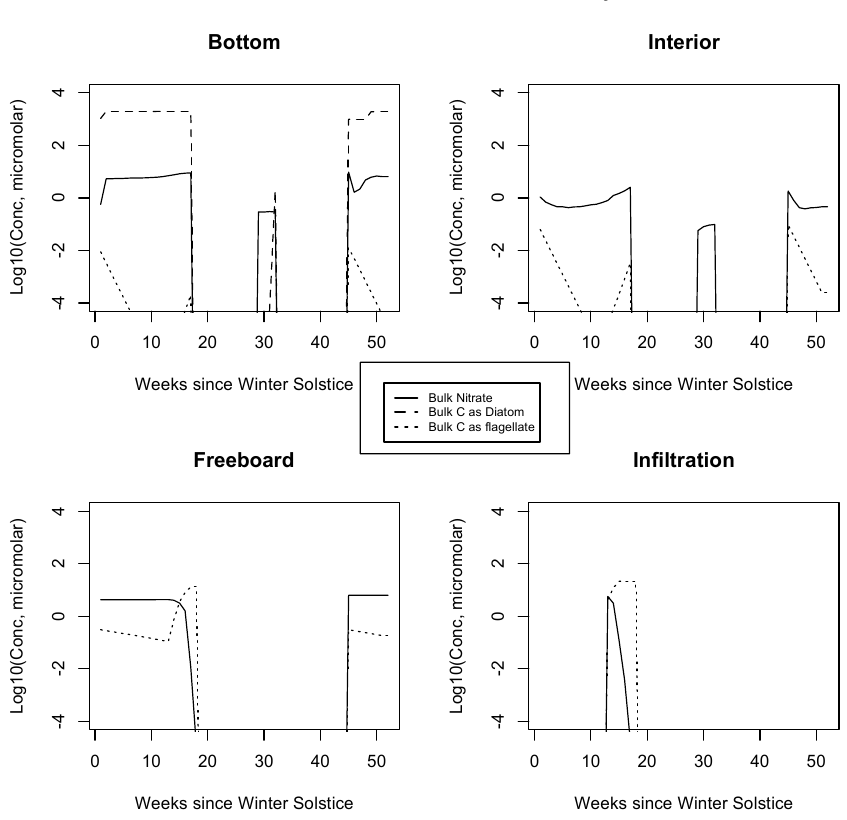
Figure 3. Sea of Okhotsk, bulk nitrogen and carbon concentrations in the baseline run for the four numerical habitat levels. All values are base 10 logarithms for the major indicator atom types from concentrations computed in micromolar. Silicate is not shown since it is present in excess. Phaeocystis also goes unrepresented in the interest of simplification.